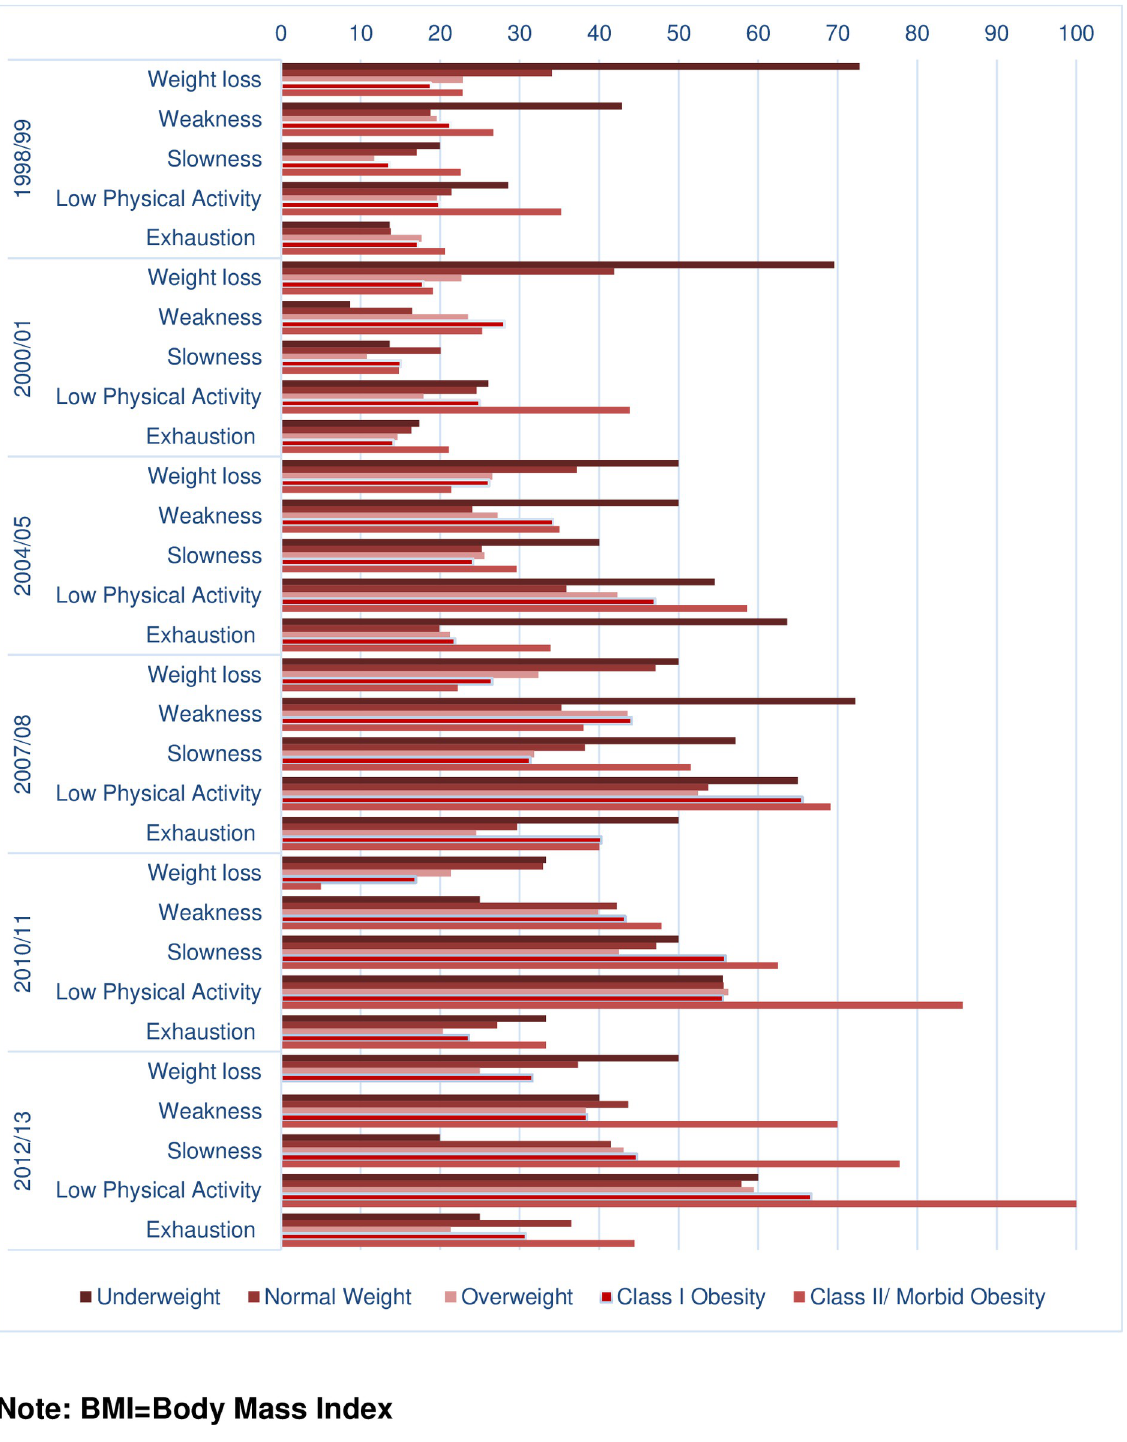
Fig 3. Percent of each frailty criterion by BMI categories over time among non-frail older Mexican Americans at baseline (N = 1,648).